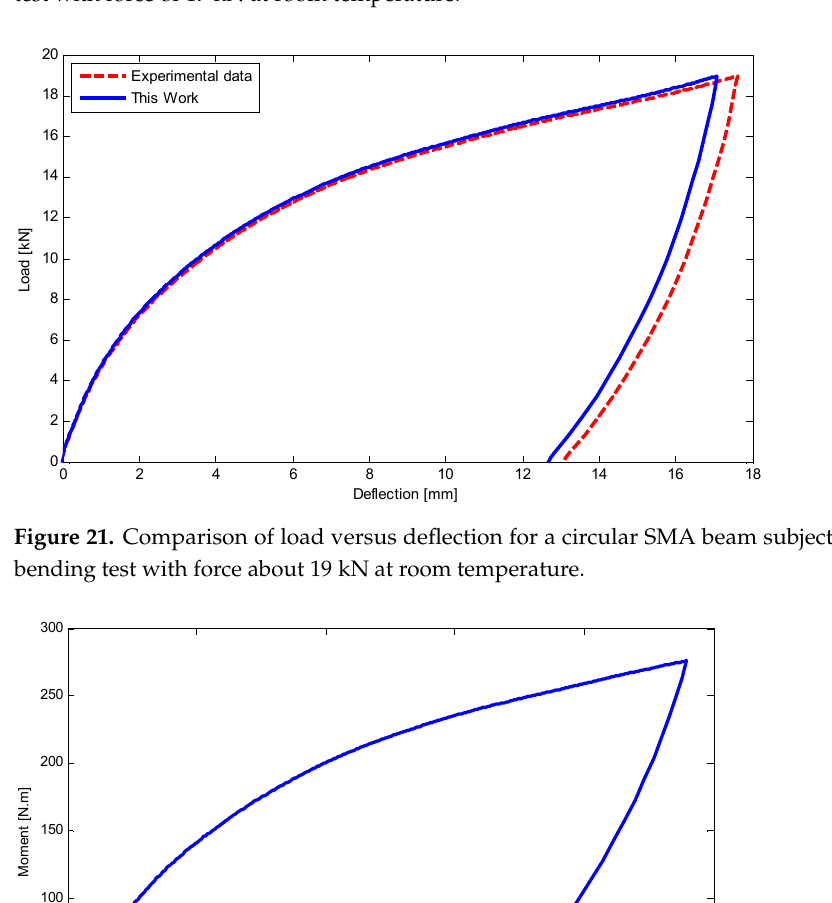
four-point bending test with the force of 17 kN at room point bending test with the force of 17 kN at room temperature.